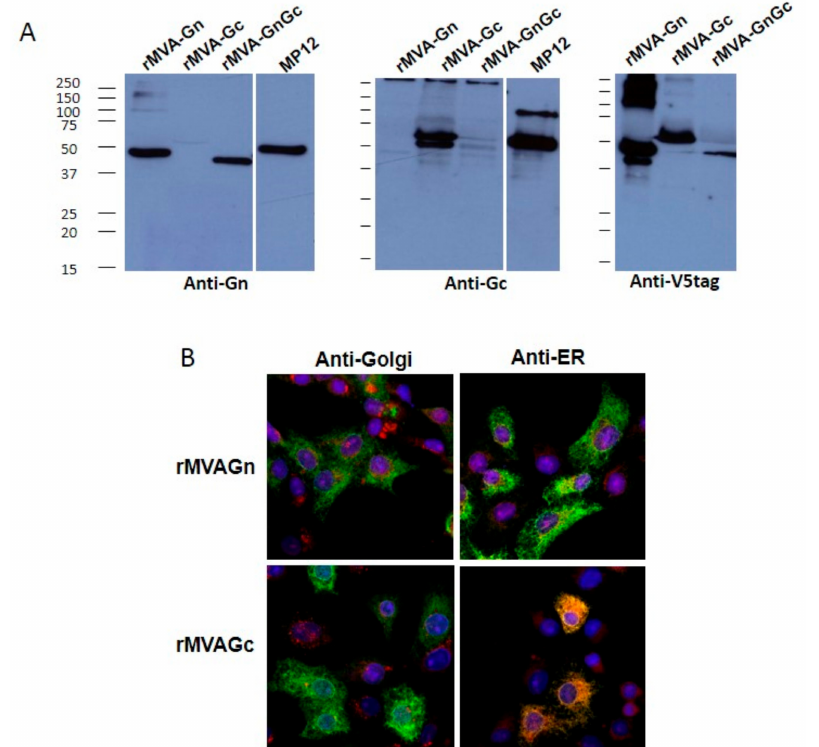
Figure 1. Expression and subcellular localization of recombinant Gn and Gc upon modified vaccinia Ankara (MVA) infection. ( A ). Western blot of di ff erent MVA infected BHK-21 cell extracts probed with mAb 84a antiGn or a rabbit polyclonal serum antiGc. The antiV5 tag mAb was used to compare the Gn and Gc expression levels and to confirm the expression of the full-length antigen. As a positive control a RVFV-MP12 infected cell extract was used. Numbers indicate relative molecular mass in kilodaltons. ( B ). Confocal immunofluorescence images of MVA infected Vero cells. Expression of Gn or Gc was detected with anti V5 tag mAb (green). Intracellular membranes were labeled with either antihuman mannosidase-II (Golgi) or anticalreticulin (ER) mAbs (red fluorescence) as indicated. Nuclei were labeled with DAPI stain (blue). All panels correspond to merged fluorescence images. Colocalization of Gc and ER membranes is evidenced by yellow-orange